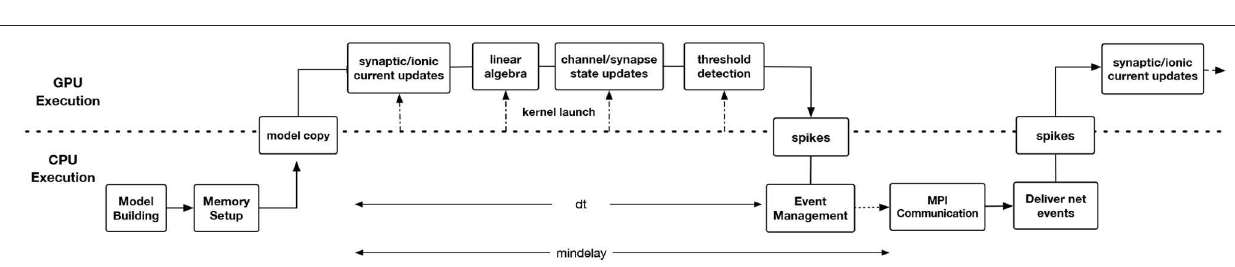
FIGURE 5 | Timeline showing the workflow of GPU-enabled CoreNEURON execution. The Model Building and Memory Setup phases are executed on CPU by NEURON and CoreNEURON respectively. The latter performs an in-place memory AoS to SoA transformation and node permutation to optimize Gaussian elimination. The CoreNEURON in-memory model is then copied to GPU memory using OpenACC APIs. All time step integration phases including threshold detection for event generation and event delivery to synapse models take place on the GPU. At the end of each timestep ( dt ), the generated spike events are transferred to the CPU. Conversely, all the spike events to be delivered during a step are placed in a per-synapse type buffer and transferred at the beginning of each timestep to the GPU. At the end of mindelay interval all spikes destined to other processes are transferred using MPI